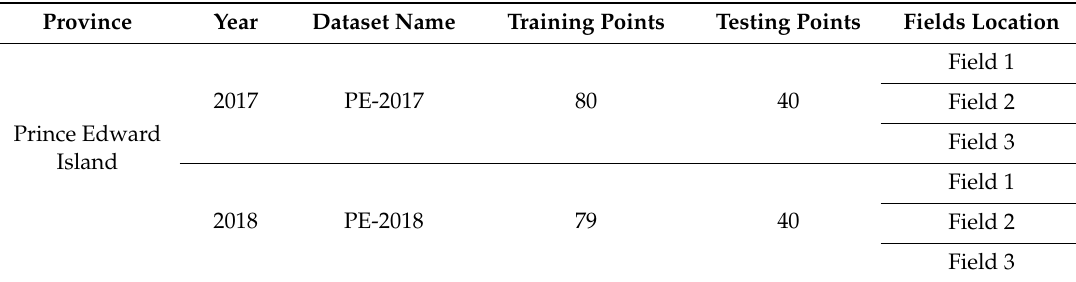
Table 1. Description of study sites, study years, datasets, the data used for training and testing of machine learning algorithms and potato fields used for data